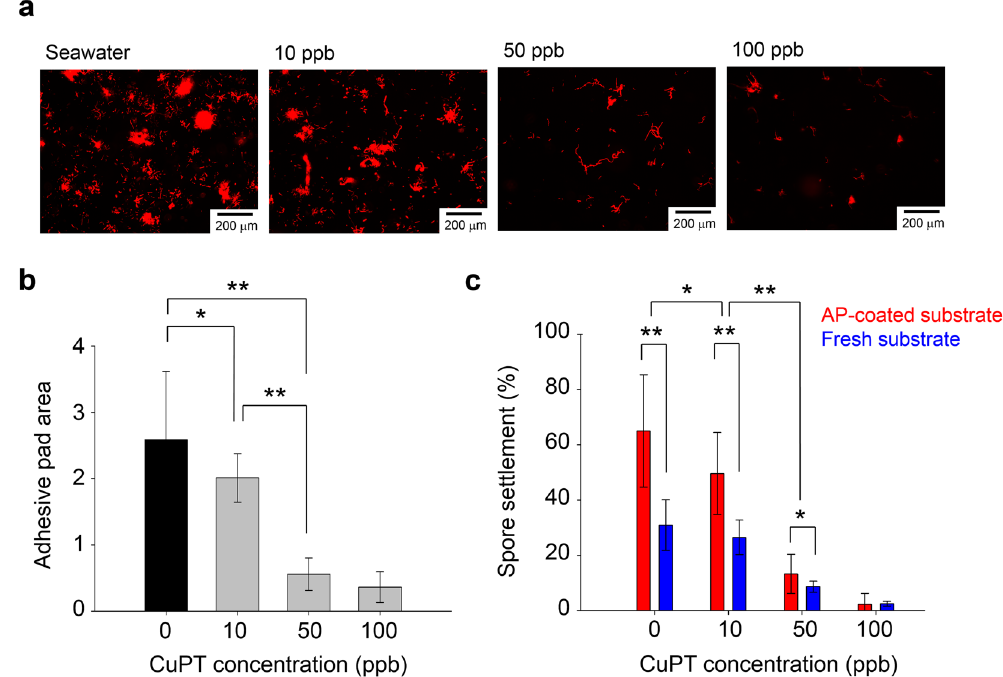
Figure 5. ( a ) Fluorescence microscopy images of the Cy5-treated surface of glass exposed to Ulva spore suspension in natural seawater containing CuPT at various concentrations under the summer condition for 24 h. ( b ) Quantitative comparison of adhesive pad areas calculated from images in ( a ). ( c ) Spore settlement efficiency on the fresh and AP-coated glass surfaces exposed to Ulva spore suspension in natural seawater without biocides under the summer condition for 24 h. Some p -values below 0.05 ( * ) and 0.001 ( ** ) with n = 18 or 19 are represented in ( b and c ).